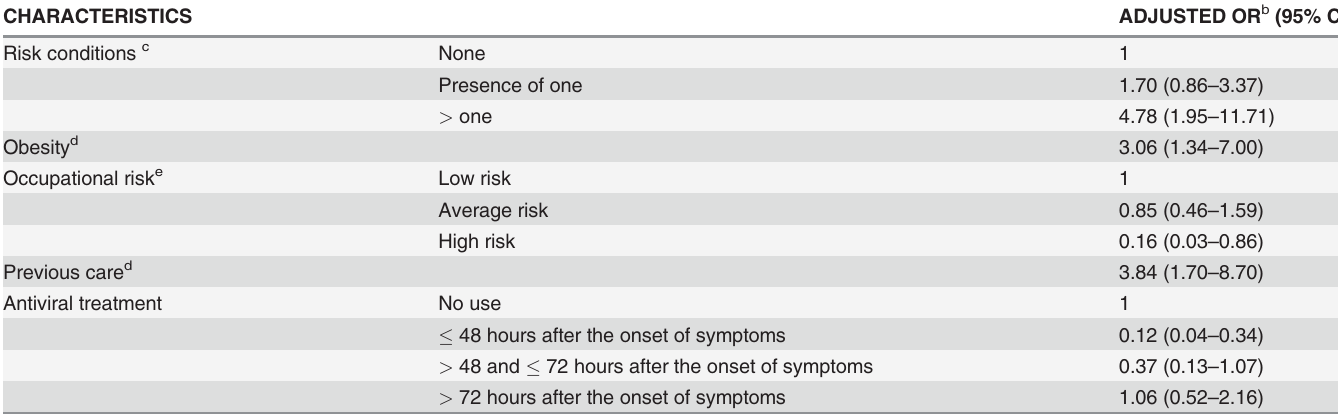
Table 5. Risk factors for death from in fl uenza A(H1N1)pdm09 associated with Severe Acute Respiratory Illness in adults a , metropolitan regions of S ã o Paulo and Campinas, state of S ã o Paulo, Brazil, 2009.